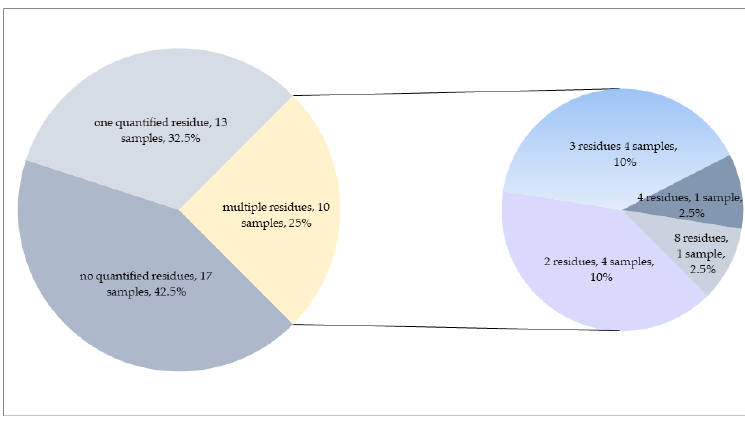
Figure 5. Number of quantified residues in parsley samples.